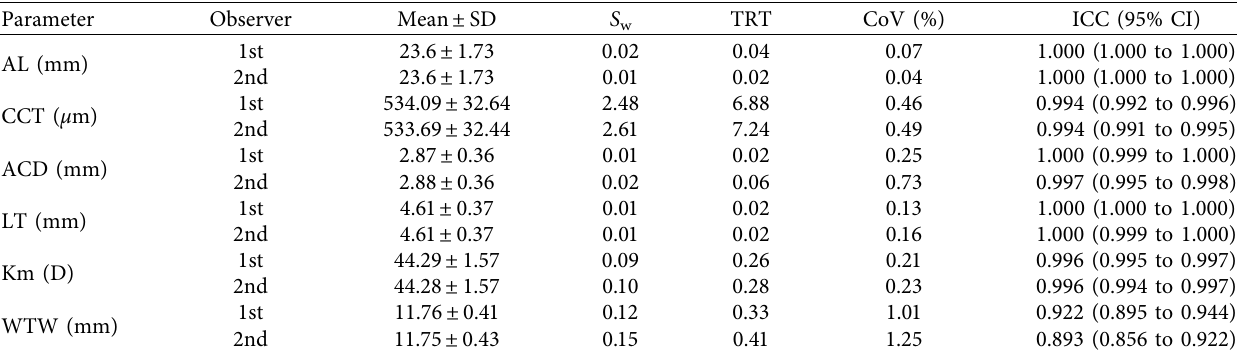
Table 3: Intraobserver repeatability outcomes for biometric measurements obtained using IOLMaster 700 swept-source optical coherence tomography in cataract